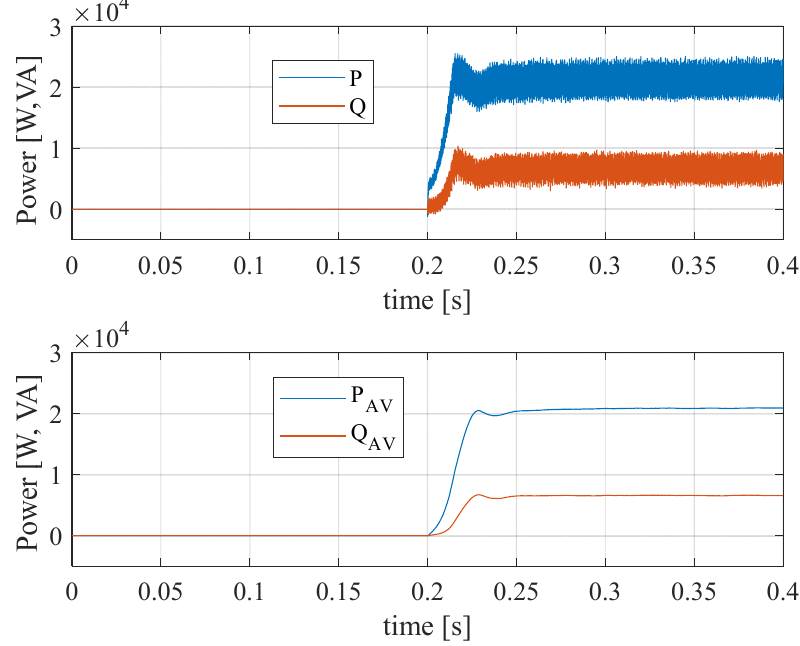
Figure 18. Active and reactive power during parallel cooperating of both PMSM motor and ICE engine with